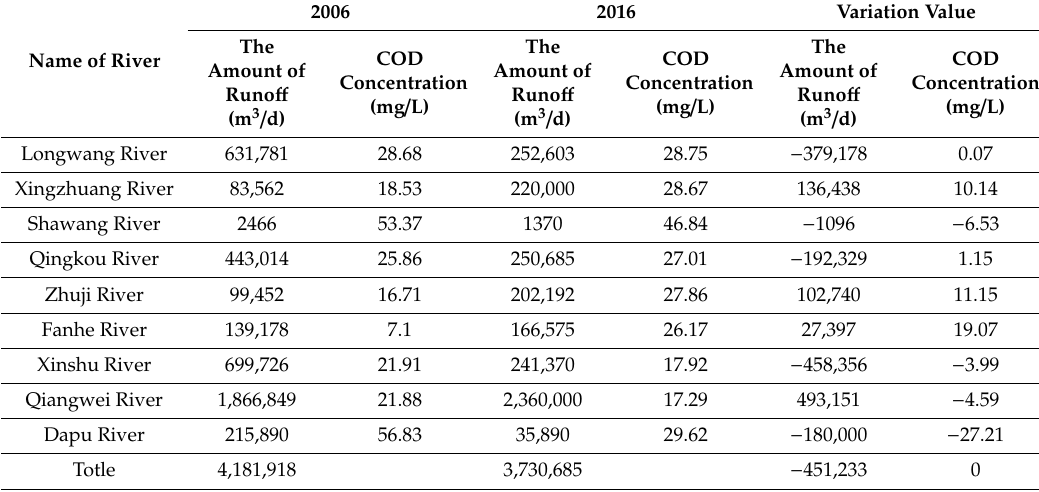
Figure 8. Changes of coastline and isobath in Haizhou Bay from 2006 to 2016. Table 2. The amount of runo ff and chemical oxygen demand (COD) concentration of the nine main rivers in Haizhou Bay from 2006 to